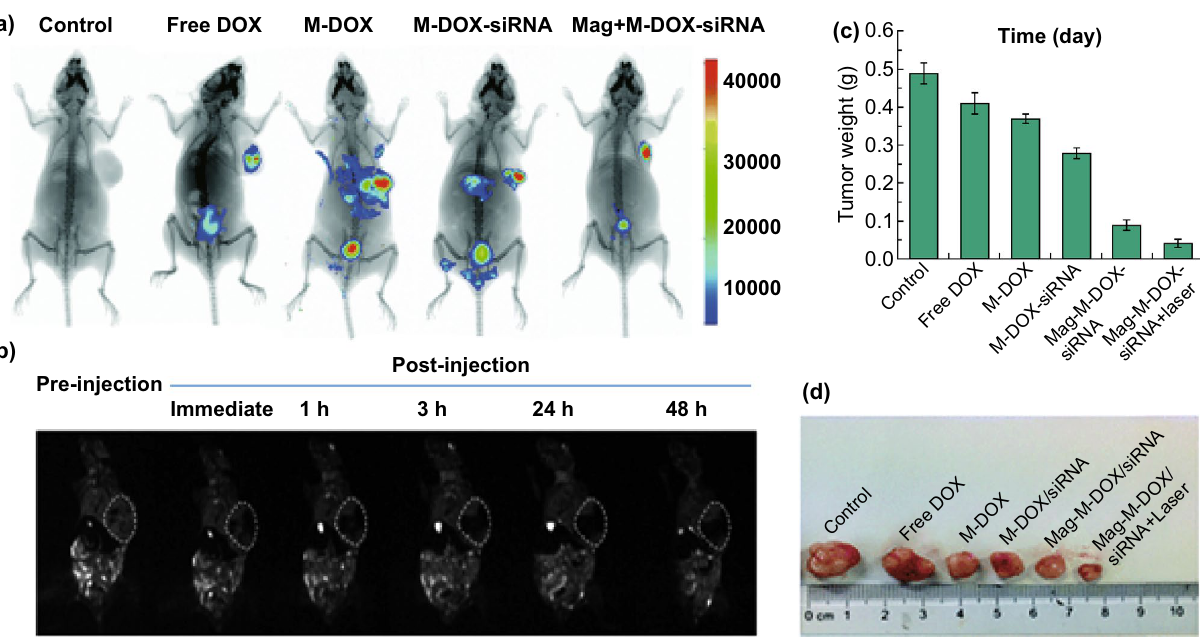
Fig. 6 a Magnetic biodistribution of DOX/siRNA‑loaded magnetic mesoporous TiO 2 nanocarriers 12 h after administration in both control and tumor‑bearing mice. b Captured T 2 ‑weighted MRI images during pre‑injection and post‑injection of the core–shell nanocarriers. Tumor regions are shown with the white, dashed circles. c The measured weight of the tumors of the treated and control mice. d Images of the tumors from the treated and control mice after the last injection (Abbreviation; M: Fe 3 O 4 @TiO 2 @mesoporous TiO 2 and Mag: under a magnetic force). Adapted from Ref. [175] with permission from the Royal Society of